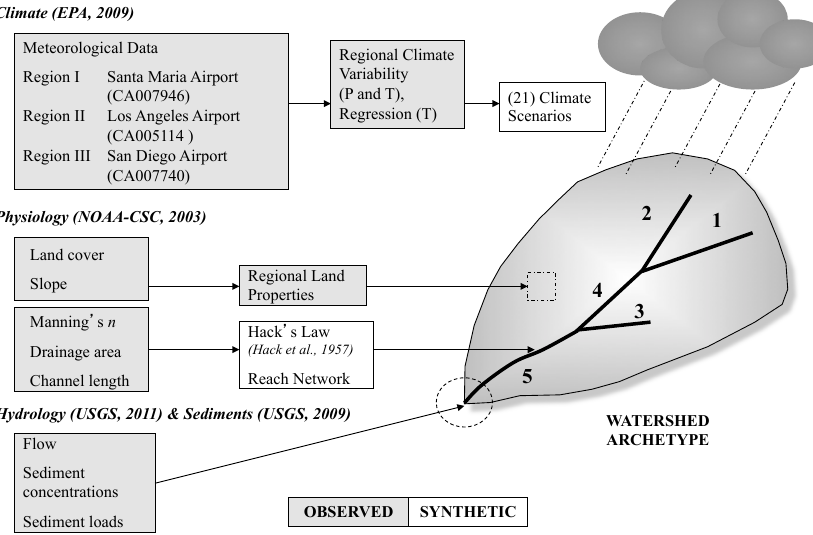
Fig. 2. Methodology for development of regional watershed archetypes. Shaded boxes indicate the usage of observed meteorological, land cover and hydrologic data (sources listed); non-shaded boxes indicate the usage of empirical and/or synthetic